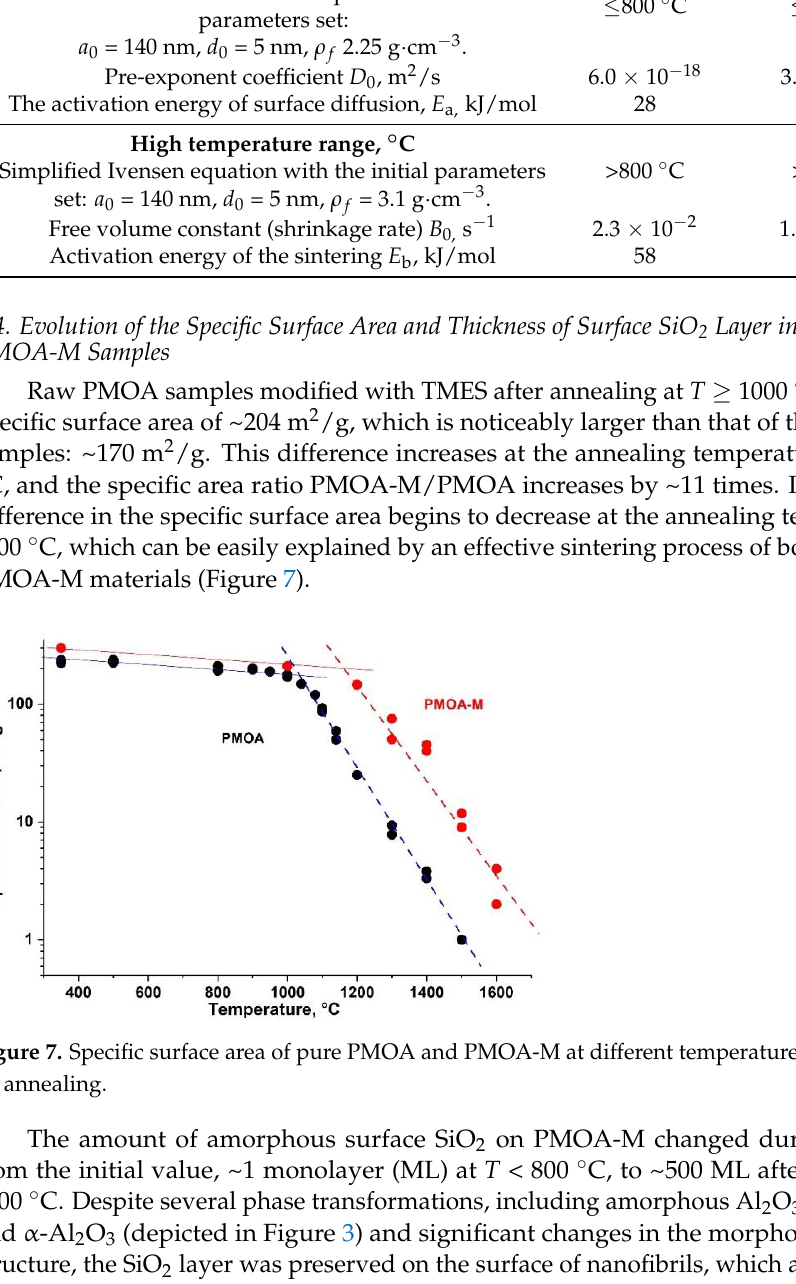
Figure 8. 200 kV HRTEM (TOPCON 002B) image of a PMOA-M sample annealed at 1400 °C. A layer of amorphous SiO 2 of 5.8 nm thickness or 17 ± 2 ML covers the surface of the crystalline Al 2 O 3 fibril. The number of SiO 2 molecules deposited per unit surface PMOA may be estimated as: